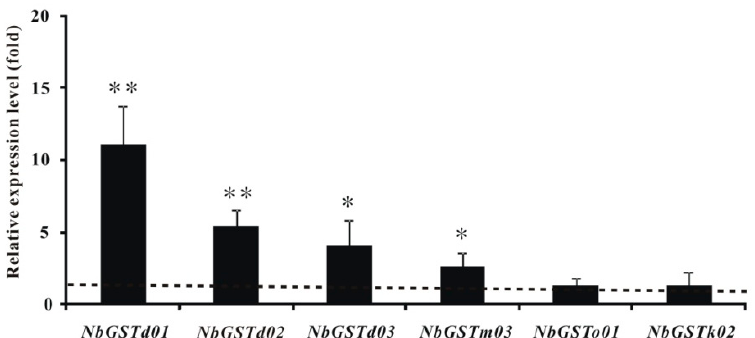
Figure 5. Fold-expression changes in selected GSTs in the fenpropathrinresistant N. barkeri strain relative to its susceptible strain. Bars represent mean ± standard deviation. Asterisks indicate significant difference by t -test, * p < 0.05 or ** p < 0.01.